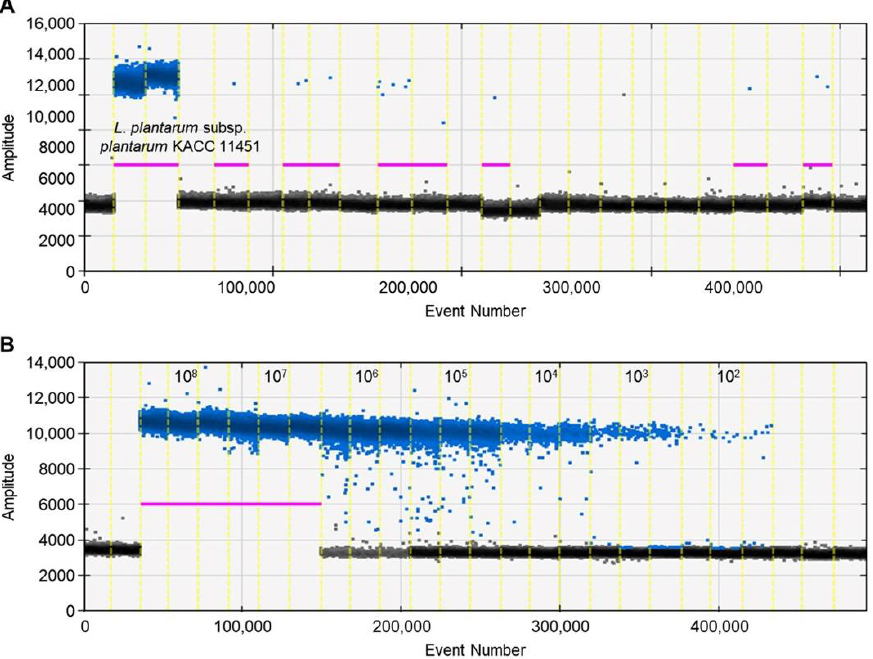
Figure 2. Assessment of primer specificity and sensitivity using ddPCR. The positive and negative droplets classified as the thresholds of individual wells are indicated in blue and black, respectively. The threshold is determined by the droplet reader and is shown as a horizontal line. ( A ) Specificity of primer by ddPCR; ( B ) quantification of genomic DNA of L . plantarum subsp. plantarum KACC 11451 by ddPCR. Table 3. Quantification of genomic DNA extracted from pure culture and spiked milk sample.